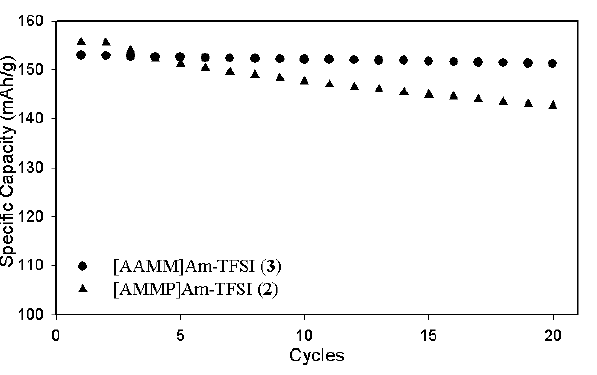
Figure 4. Dependence of the discharge capacities of the cell with the ILs on the cycle